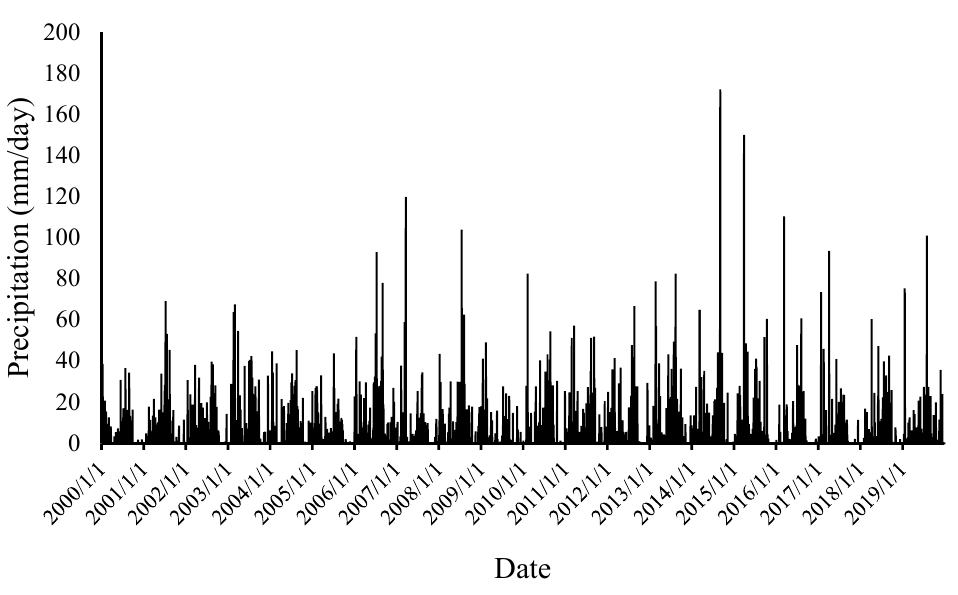
Figure 3. Daily mean precipitation of the study area from 2000 to 2020 based on the Tropical Rainfall Monitoring Mission (TRMM) data.